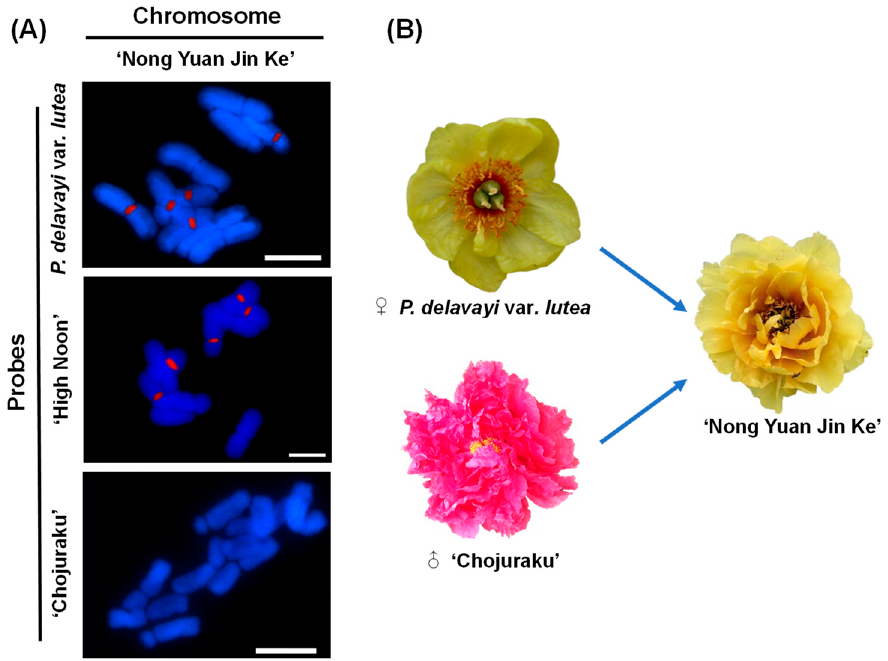
Figure 7. GISH analysis of mitotic pairings in ‘Nong Yuan Jin Ke’ using P. delavayi var. lurea , ‘High Noon’ and ‘Chojuraku’ as gDNA probes. ( A ) GISH results, bar = 10 μ m; ( B ) morphylogy of ‘Nong Yuan Jin Ke’ and its parents.